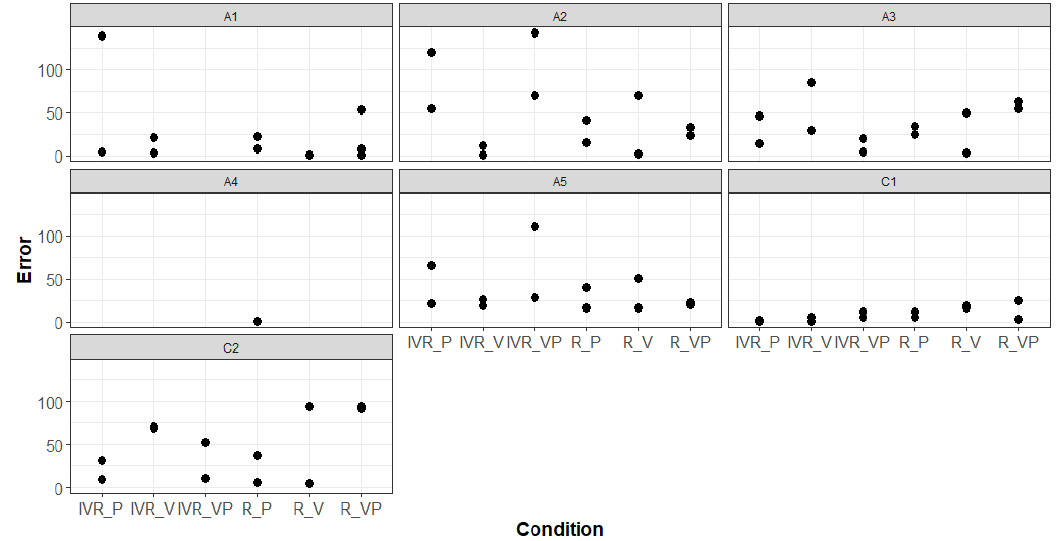
Figure 3. Self-turn error of single observations collected by each participant among conditions ( n participants = 7; n observations = 74).